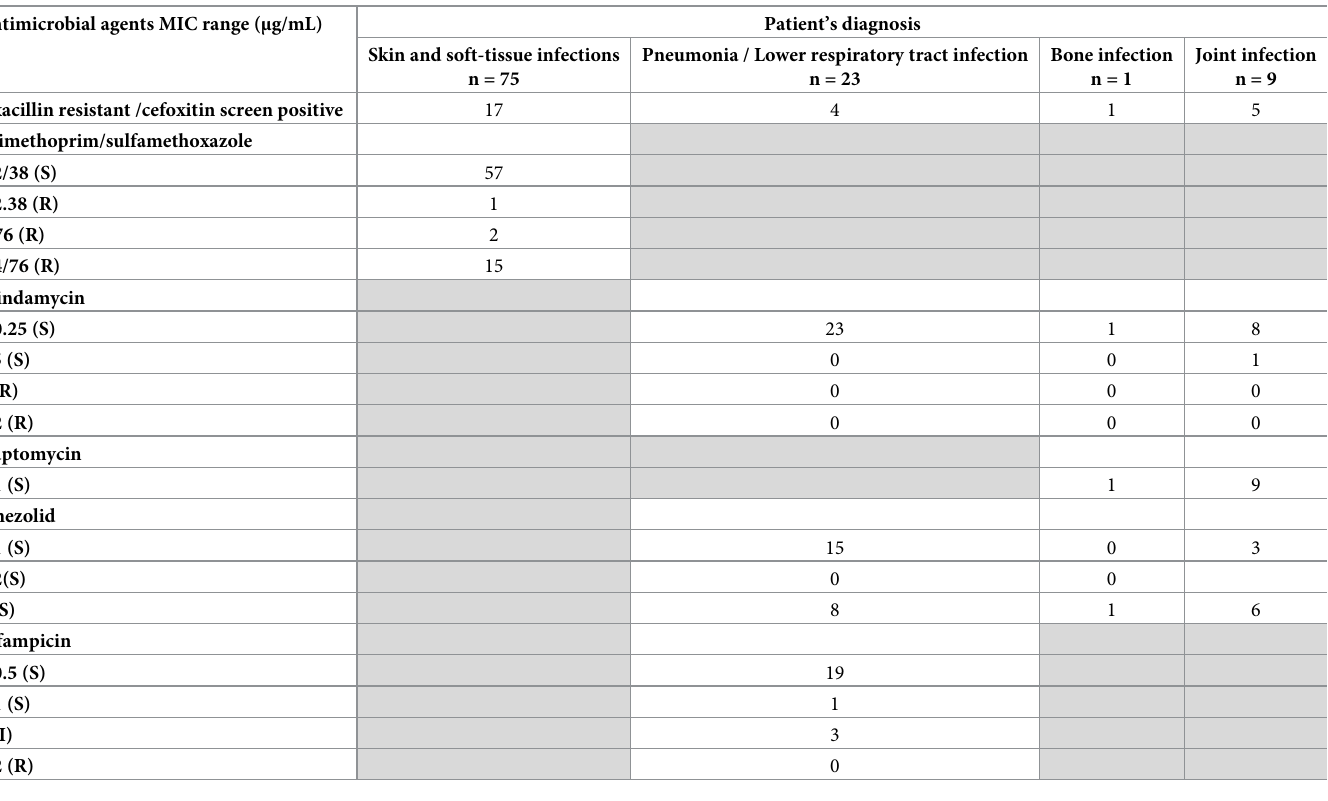
S–Susceptible, I–Intermediate resistance, R–Resistant Shaded grey boxes indicate that the antimicrobial agents is not the recommended treatment of